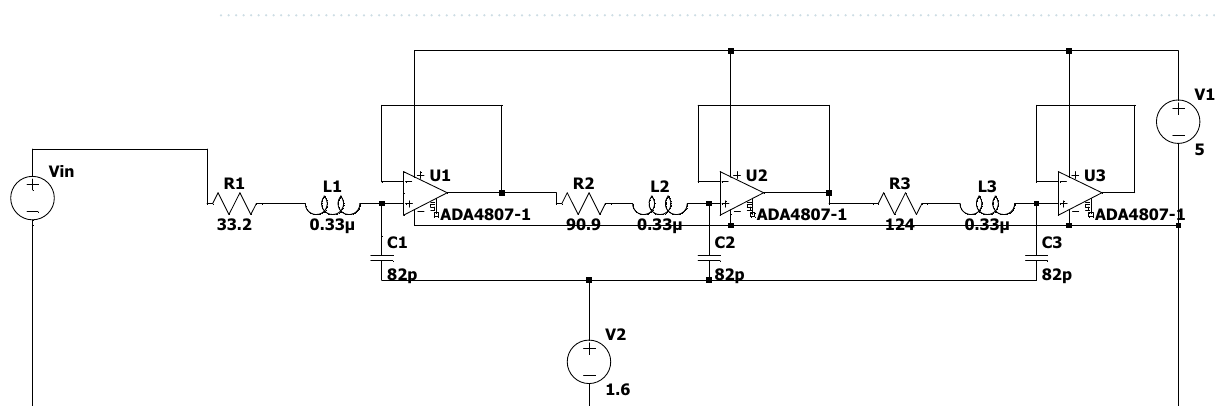
Figure 11. The TIA with driver used in the system.